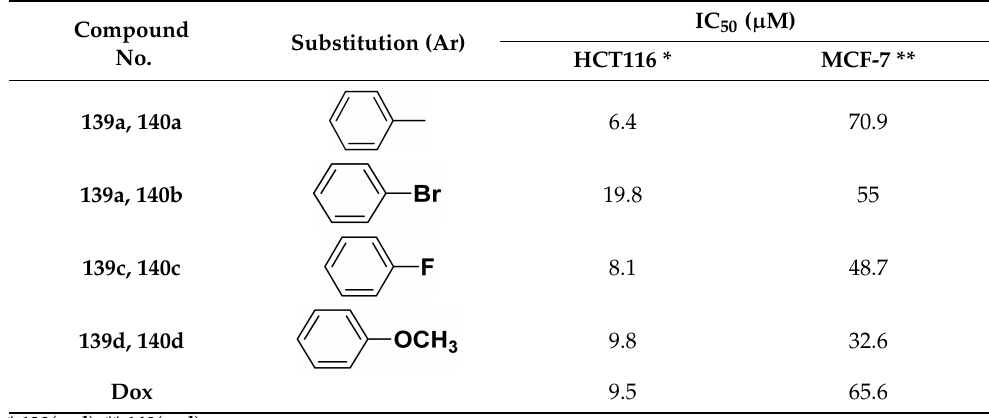
Figure 127. Structure of pyrazolo [3,4] pyridine derivatives [ 139 ( a – d ), 140 ( a – d )]. Table 114. In vitro cytotoxic activities of pyrazolo [3,4] pyridine hybrid compounds [ 139 ( a – d ), 140 ( a – d )].